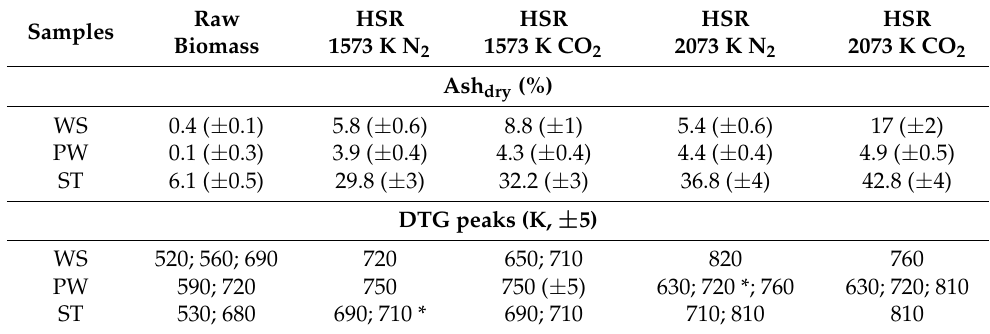
Table 2. Results of combustion tests in TGA on raw biomass and Heated Strip Reactor (HSR) chars. Samples